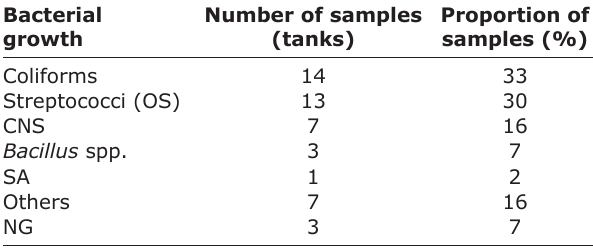
Table-4: Proportion of bovine mastitis-causing pathogens in 43 BTM samples. Bacterial